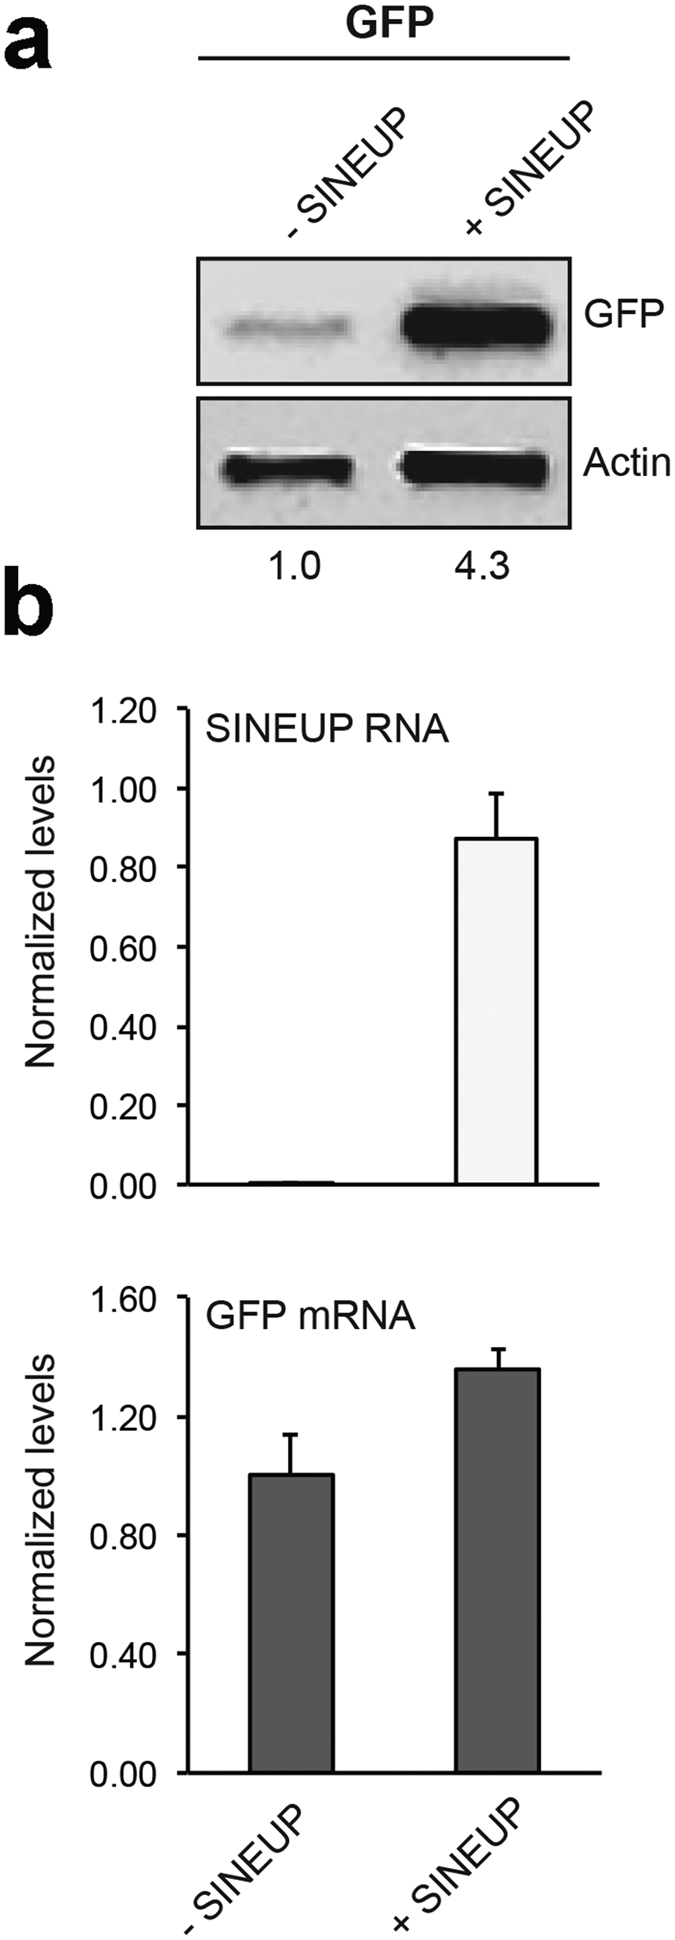
pCS2 + -SINEUP-GFP activity in vitro.HEK293T/17 were transfected with pEGFP-C2 and pCS2+/SINEUP-GFP constructs at 1:6 ratio (+SINEUP). Control cells were transfected with pEGFP-C2 and an empty control plasmid (-SINEUP). 48 hr after transfection, cells were lysed and processed for protein (a) and RNA (b) levels. Western blot was performed with anti-GFP antibody. β-actin was used as loading control. Fold-induction was calculated on Western blot images normalized to β-actin and relative to empty control samples. Expression of SINEUP-GFP (white bars) and quantity of GFP mRNA (grey bars) were monitored by Real Time PCR using specific primers. Data indicate mean ± SD. Data are representative of >3 independent replicas.